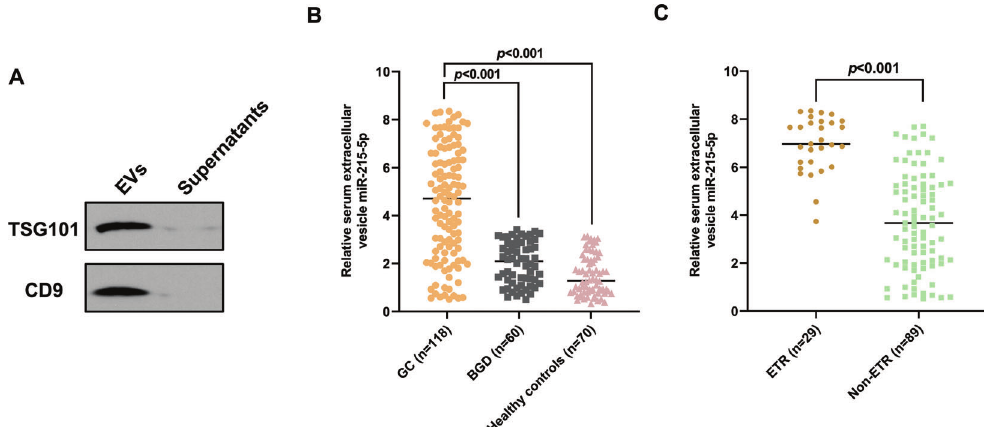
Figure 1 - Serum EV-miR-215-5p level was higher in GC patients. (A) The isolated extracellular vesicles were positive for TSG-101 and CD9. (B) Serum extracellular vesicle miR-215-5p levels were markedly higher in GC patients than those in BGD patients and healthy subjects. (C) Serum extracellular vesicle miR-215-5p levels were higher in patients with ETR than in those without ETR.